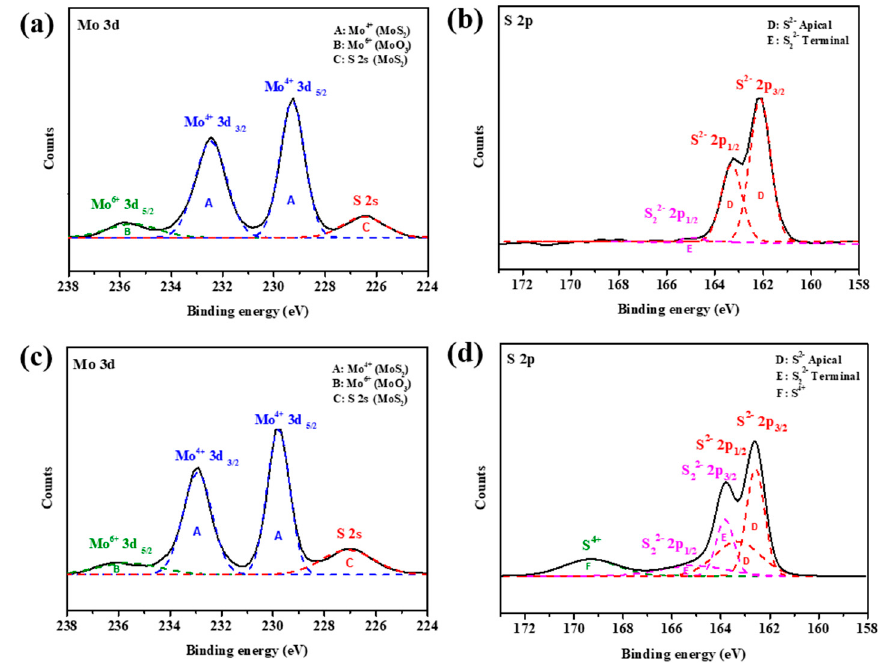
Figure 5. XPS analysis of Mo 3d and S 2p spectra of ( a , b ) OLA-protected monolayer and ( c , d ) MoS 2 - carbon.